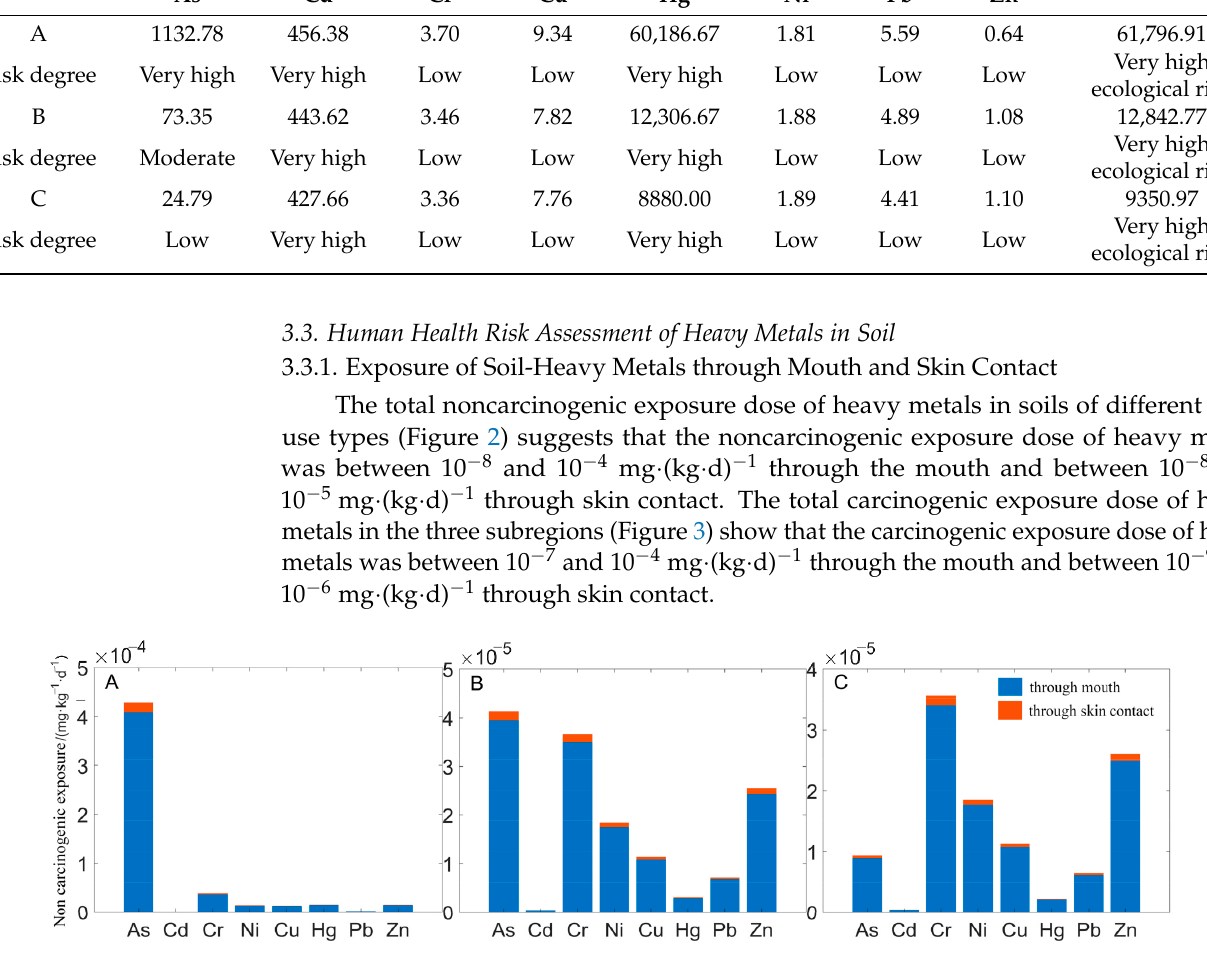
Figure 2. Noncarcinogenic exposure to heavy metals in soil. A, B and C represent area A, area B and area C, respectively.